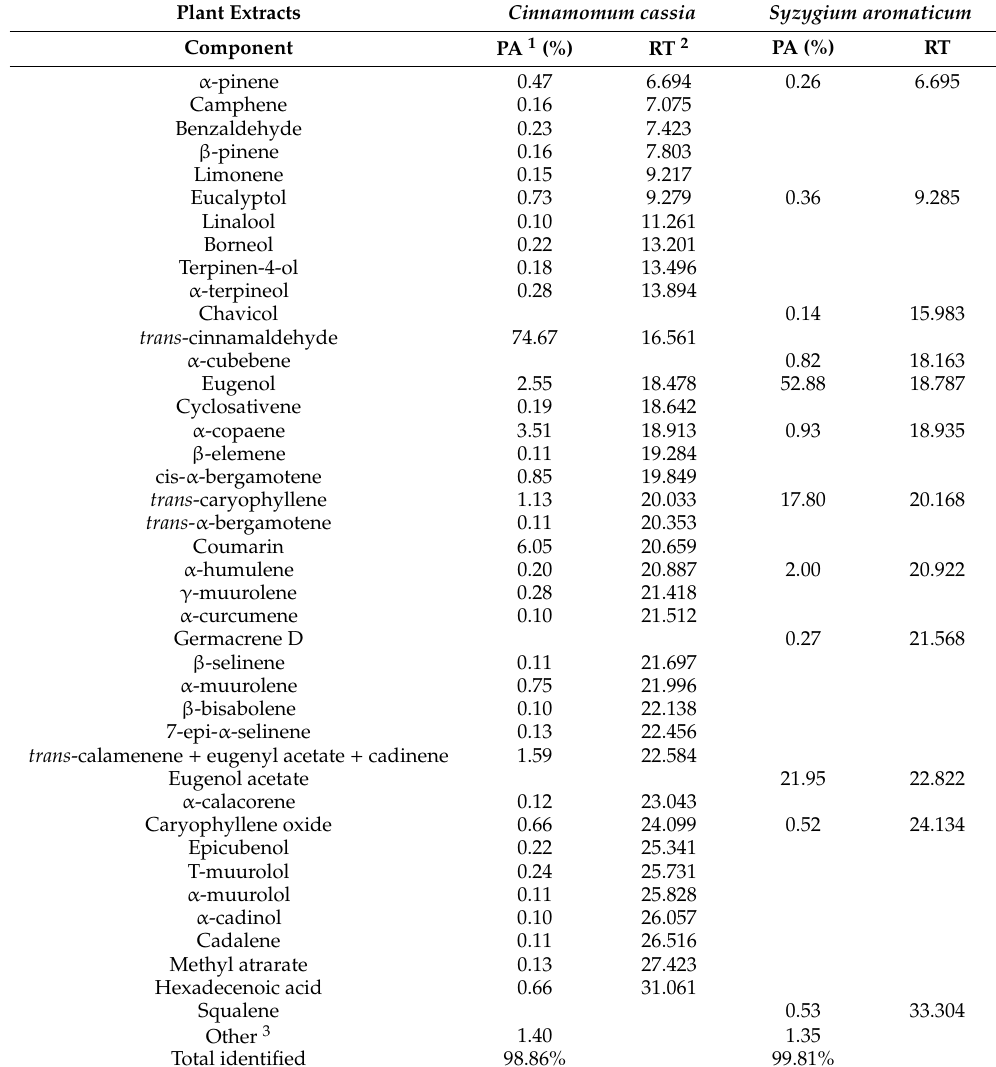
Table 1. Composition of the volatile compounds of cinnamon ( C. cassia ) and clove ( S. aromaticum ) extracts. Results are presented as means ( n = 3).